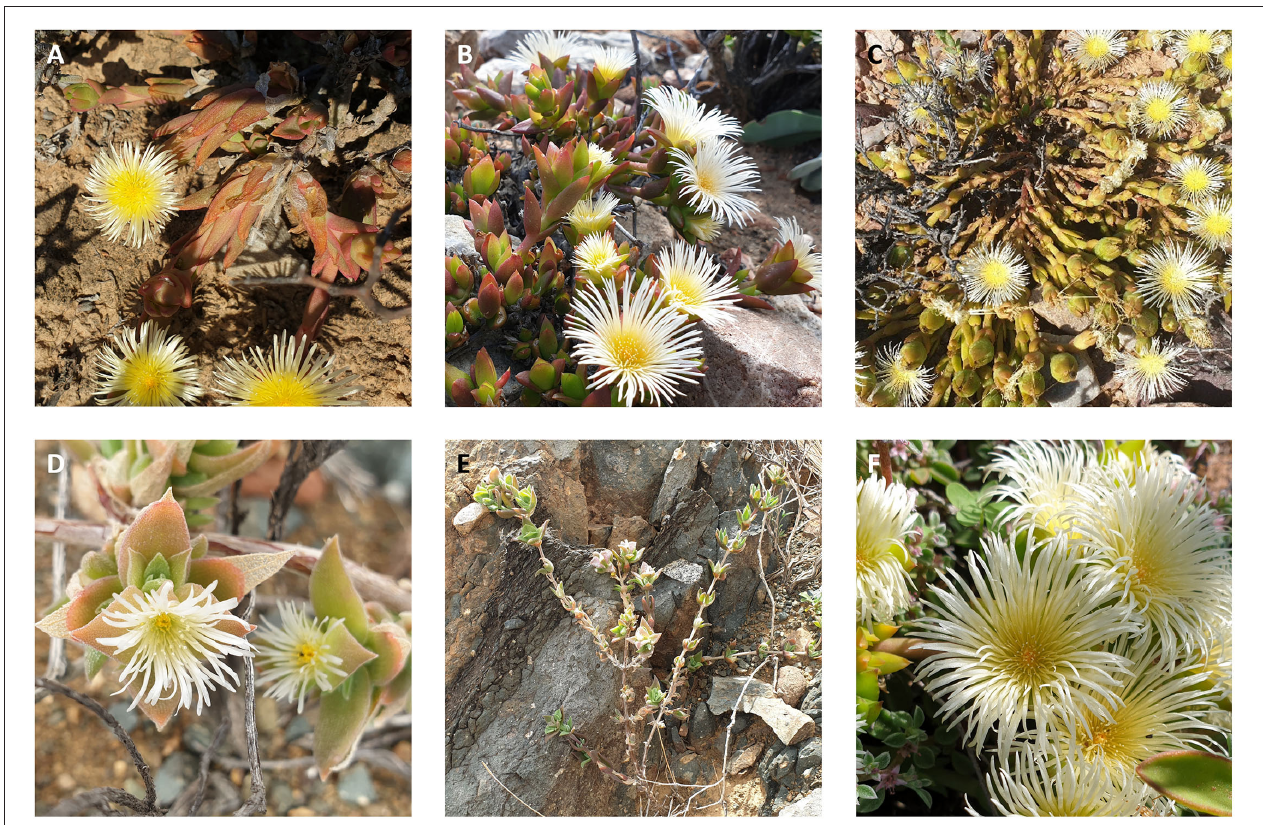
FIGURE 1 | Species of Sceletium collected from the wild. (A) Sceletium tortuosum (De Rust); (B) Sceletium strictum (Anysberg); (C) Sceletium emarcidum ; (D) Sceletium rigidum ; (E) Upright growth-form of Sceletium rigidum ; (F) Sceletium tortuosum (Ladismith 1).